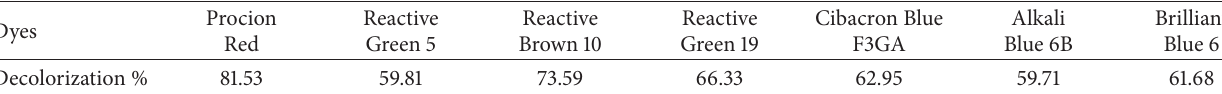
Table 2: Decolorization percentage of dyes at the end of 10min.